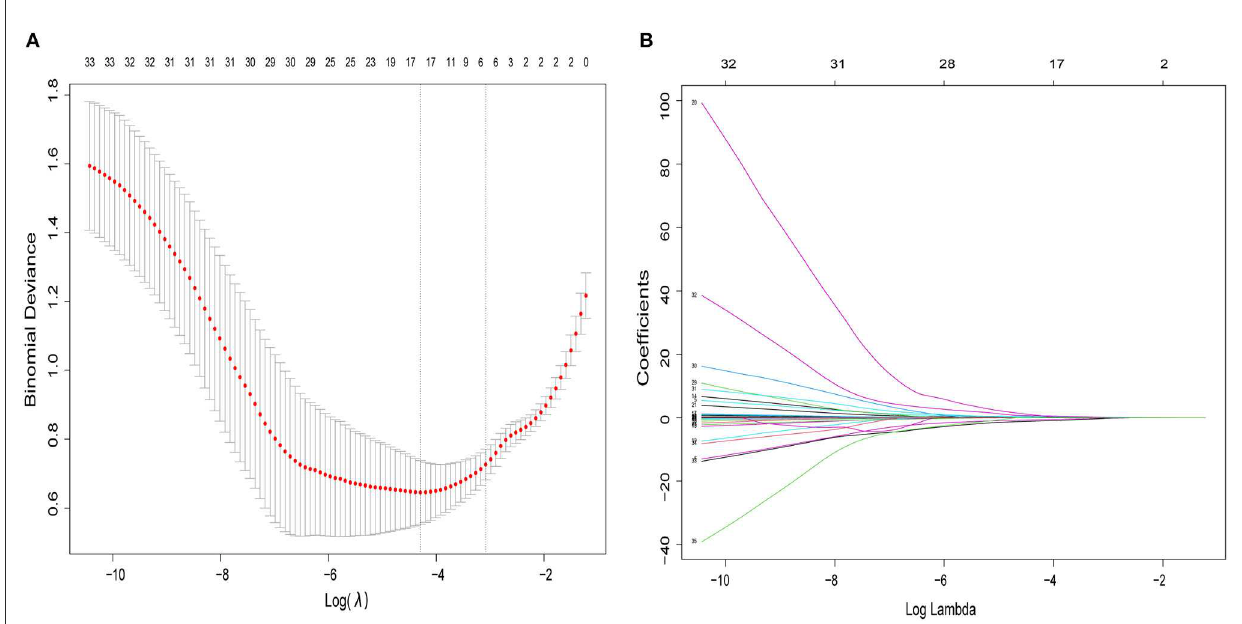
FIGURE2 The variables filtering process of the LASSO regression. In order to avoid overfitting, the LASSO regression suggested including six variables when merging OSA was the endpoint. In the variable selection process, first of all, the univariate analysis was used to select potential factors. Then, based on these potential factors, the multivariable logistic regression model was constructed. In this study, the LASSO regression was only used to ensure that the multivariable logistic regression models were not overfitting rather than for variable selection and modeling. (A) Optimal parameter (lambda) selection in the LASSO logistic regression used 10-fold cross-validation via minimum criteria. The dotted vertical lines were drawn at the best values using the minimum criteria and 1 standard error of the minimum criteria (the 1-SE criteria). (B) LASSO coefficient profiles of the 34 features. A coefficient profile plot was produced against the log (lambda) sequence. LASSO, least absolute shrinkage and selection operator; SE, standard